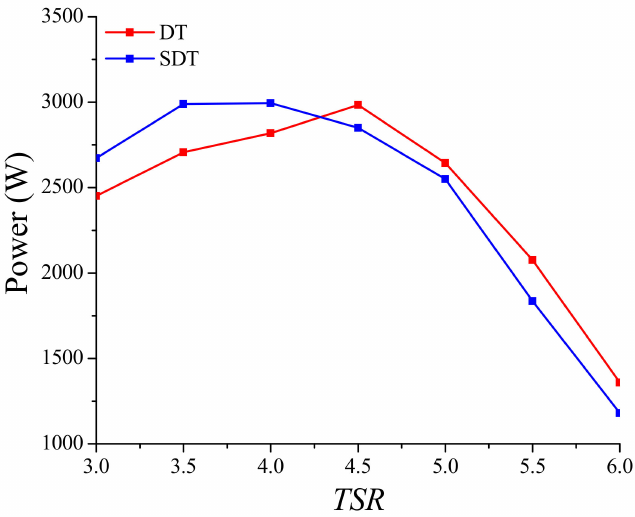
Figure 7. Power comparison between the DT and the SDT.